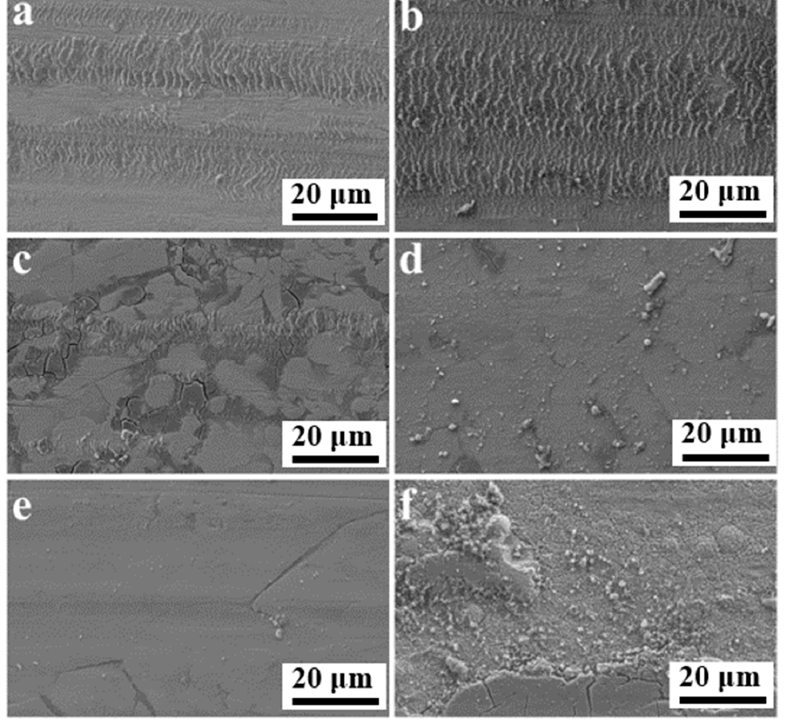
Figure 11. SEM of friction and wear surface of ( a ) Ni-P, ( b ) Ni-P-CS, and ( c – f ) Ni-P-CS composite coatings heat-treated at 300 °C~600 °C.